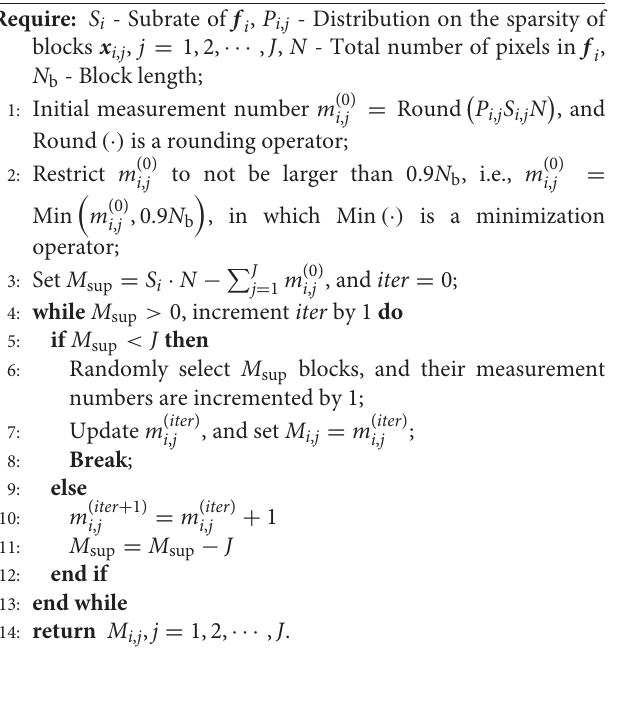
Algorithm 1 | Allocating the appropriate numbers of Compressive Sensing (CS) measurements to blocks.